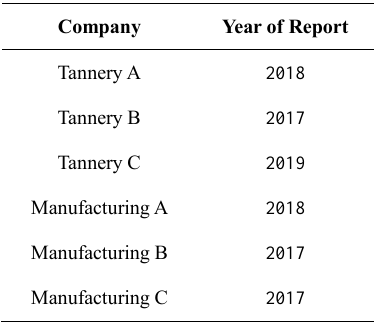
Table 2. Distribution of reports by publication